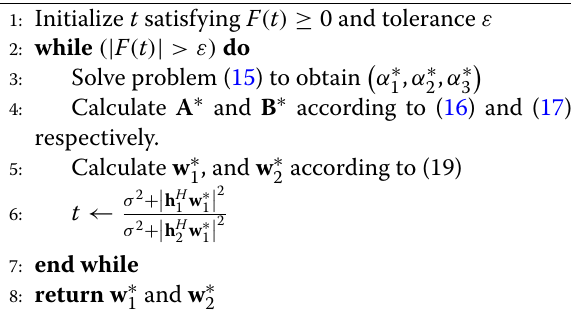
Algorithm 1 The optimal solution to problem